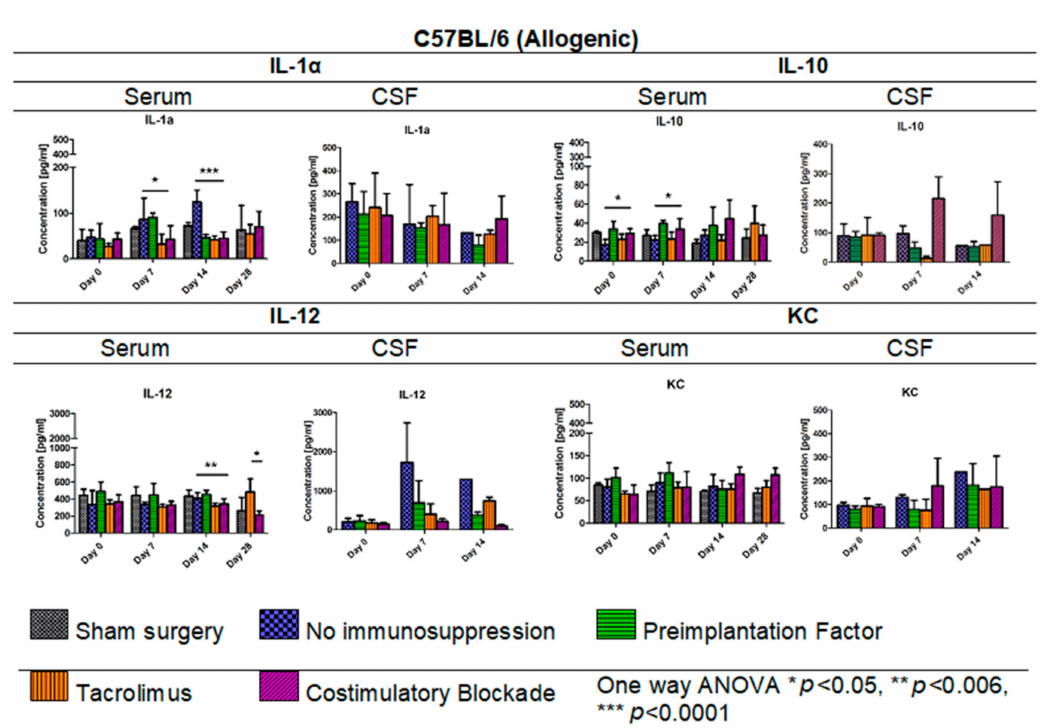
Figure 9. Cytokine levels in serum and CSF samples in C57BL/6 allogenic mouse model: IL-1 α , IL-10, IL-12, and KC levels in serum and CSF samples were assessed in allogeneic mice. The most significant differences between variants under study (different immunomodulatory regime) were detected in serum with respect to IL-1 α ( p < 0.05 on day 7, p < 0.0001 on day 14), IL-10 (day 0 and 7, p < 0.05), and IL-12 (day 14, p < 0.006) concentrations. There were no significant differences in KC levels. Unpaired Student’s t -test; data are presented as mean, error bars: SD; the total number of samples: n = 65, total number per variant at each time point: n = 3–5. The total number of biological replicates per group: n = 5. Abbreviations: CSF-cerebrospinal